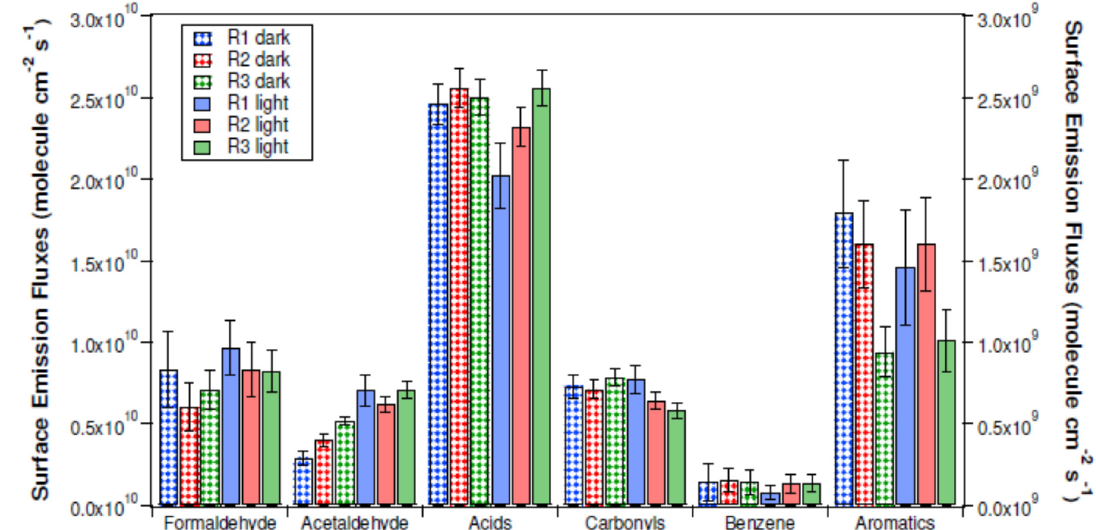
Figure 11. Surface emission fluxes (molecule cm − 2 s − 1 ) obtained for selected VOCs (formaldehyde, acetaldehyde, acids, carbonyls, aromatics, and benzene) under “dark” conditions (lozenge) and in the presence of a UV light (solid) [175] .